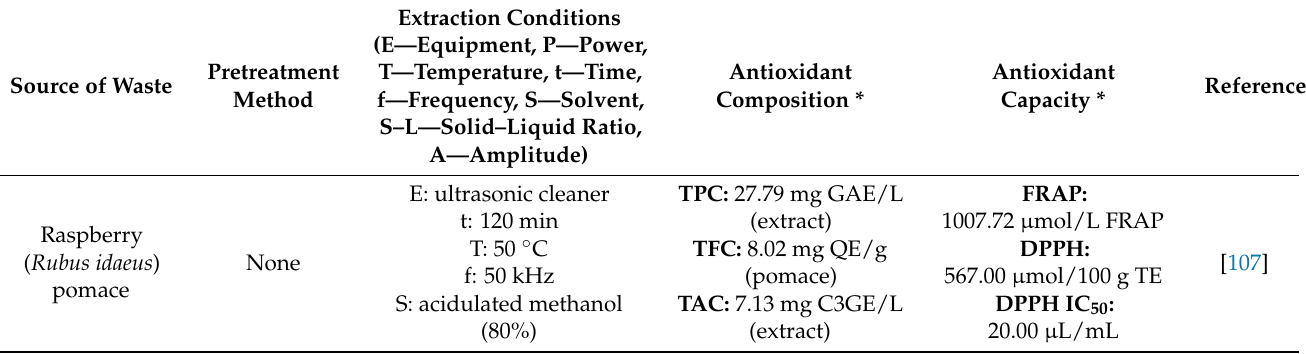
Table 6. Conditions and results for ultrasound-assisted extraction of oils and bioactive compounds from berry